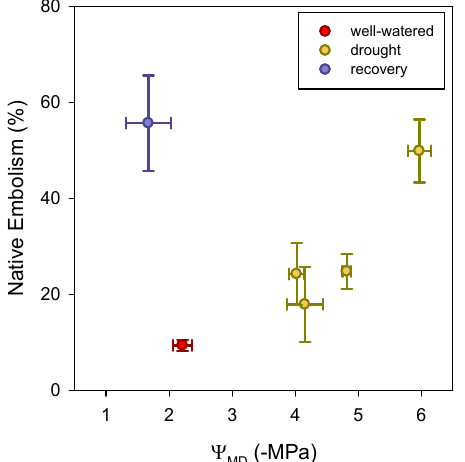
Figure 5. Time course of native xylem embolism (%) with midday water potential ( ψ MD ) for holm oak twigs well ‐ watered (red symbols), during the drought period (yellow symbols) and 7 days after plants were re ‐ watered (violet symbols). Data are mean ± SE.